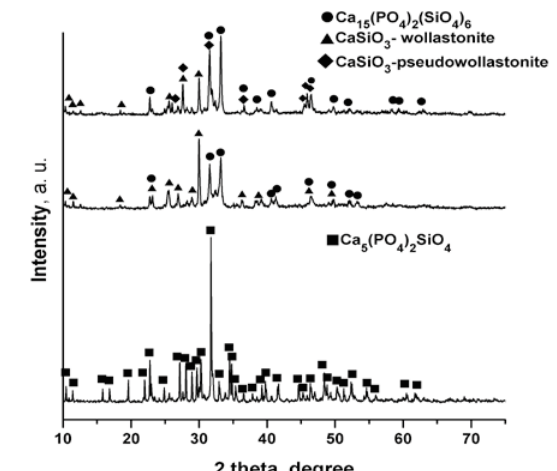
Figure 1. XRD patterns for CPS-1 sample, thermal treated at 1200 o C / 2 h (a) and for CPS-2 sample, thermal treated at 1100 o C / 2 h (b) and 1200 o C / 2 h (c)